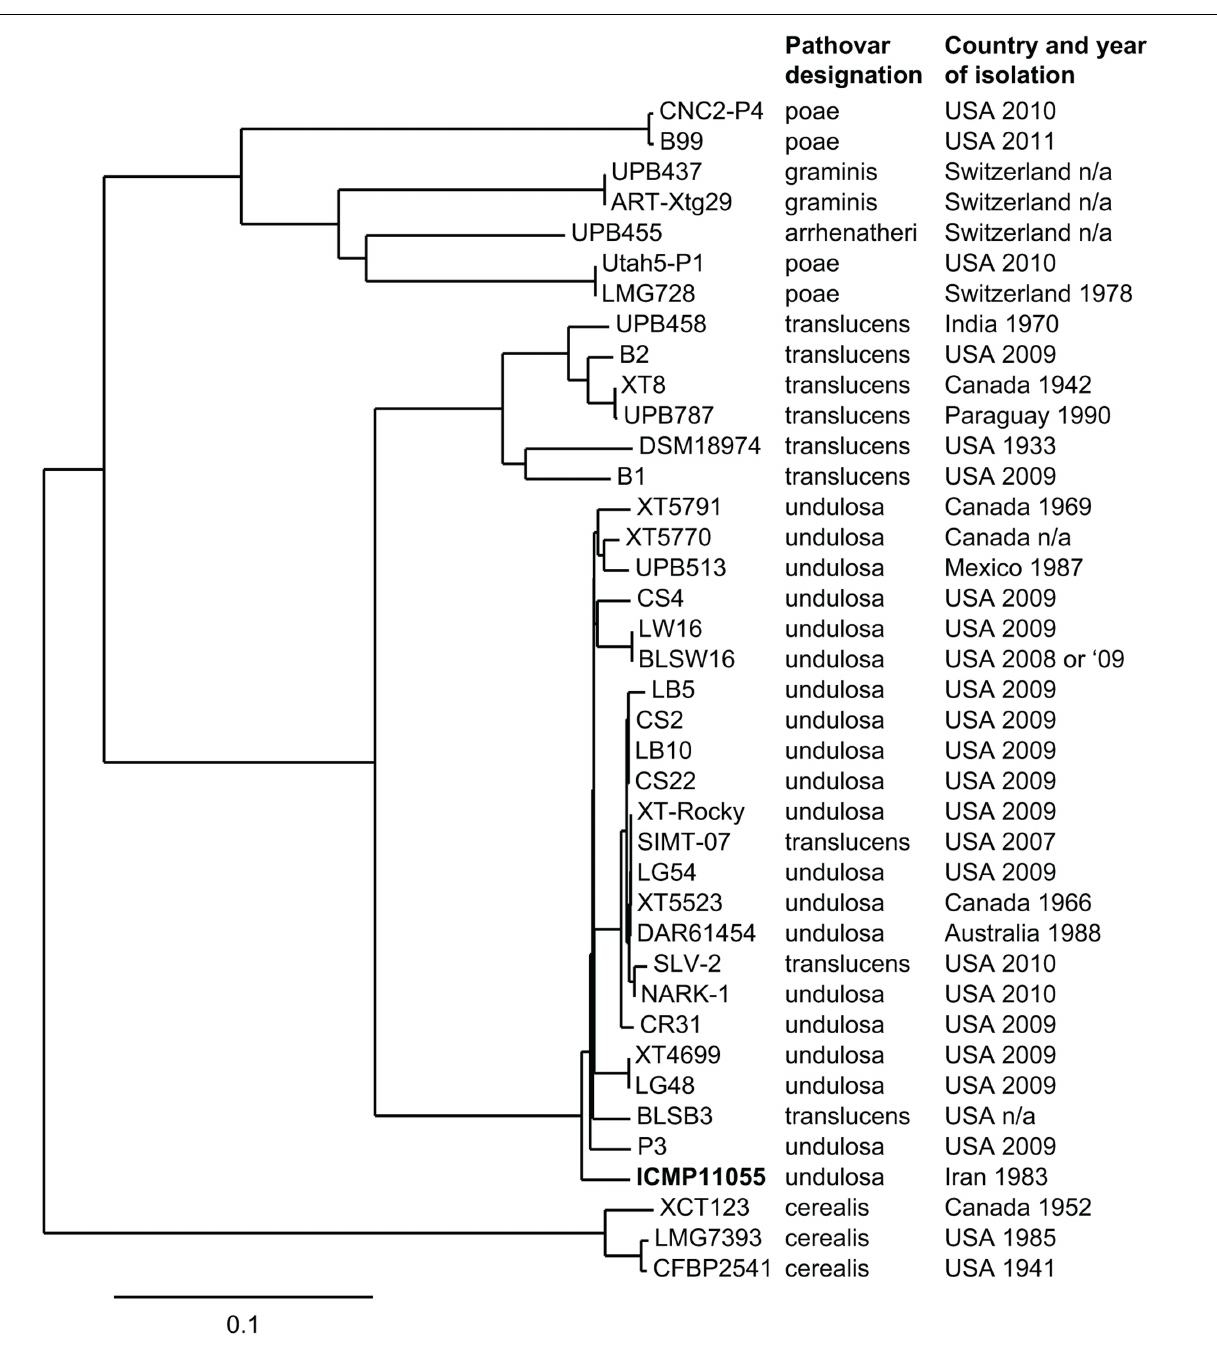
than 20 hrp (HR and pathogenicity) genes in several operons (Büttner and Bonas, 2010). The cluster is, as expected, present in ICMP11055. However, in contrast to many studied Xanthomonas strains, in ICMP11055, the hrpG and hrpX genes, which encode